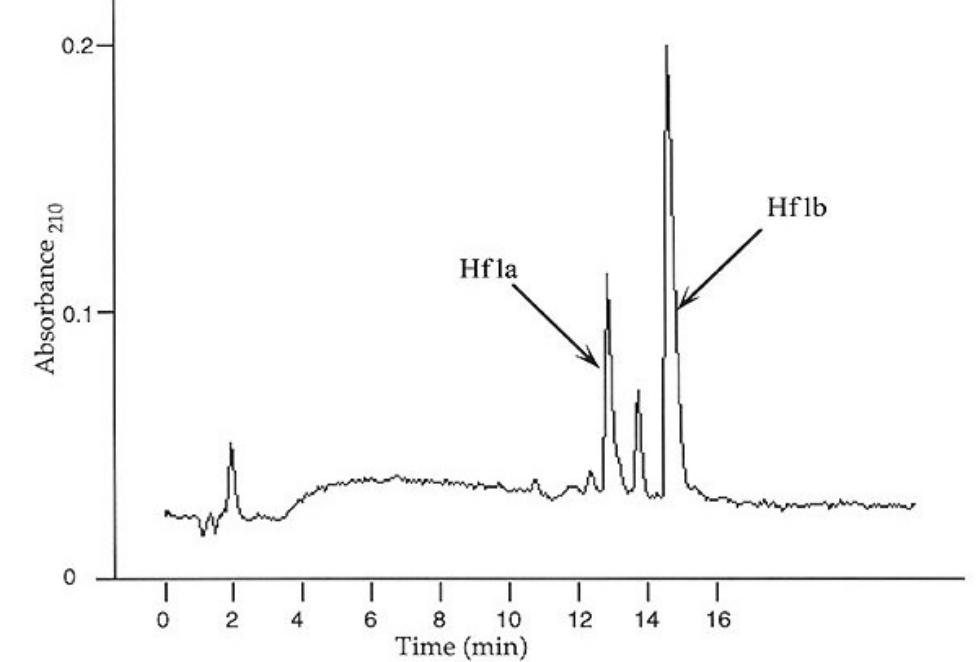
Figure 3: Secondary fractionation by HPLC of fraction A from crude H. formidabilis venom. Peaks corresponding to atracotoxins-Hf1a and b are so